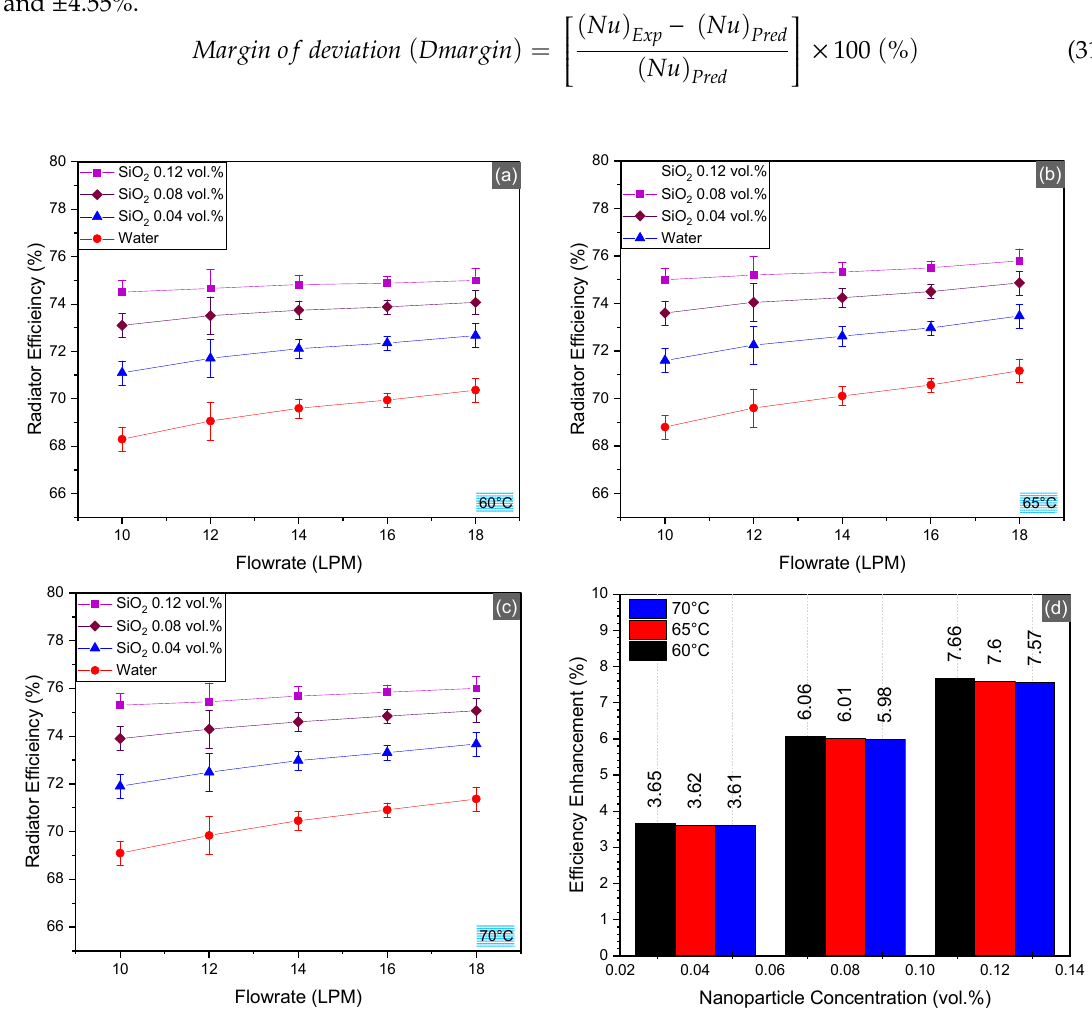
Figure 9. Total efficiency of the radiator at inlet temperatures 60–70 ℃ ( a – c ) and average Figure 9. Total e ffi ciency of the radiator at inlet temperatures 60–70 ◦ C ( a – c ) and average enhancement enhancement in efficiency for SiO 2 /water nanofluid as compared to the basefluid ( d ). in e ffi ciency for SiO 2 / water nanofluid as compared to the basefluid ( d